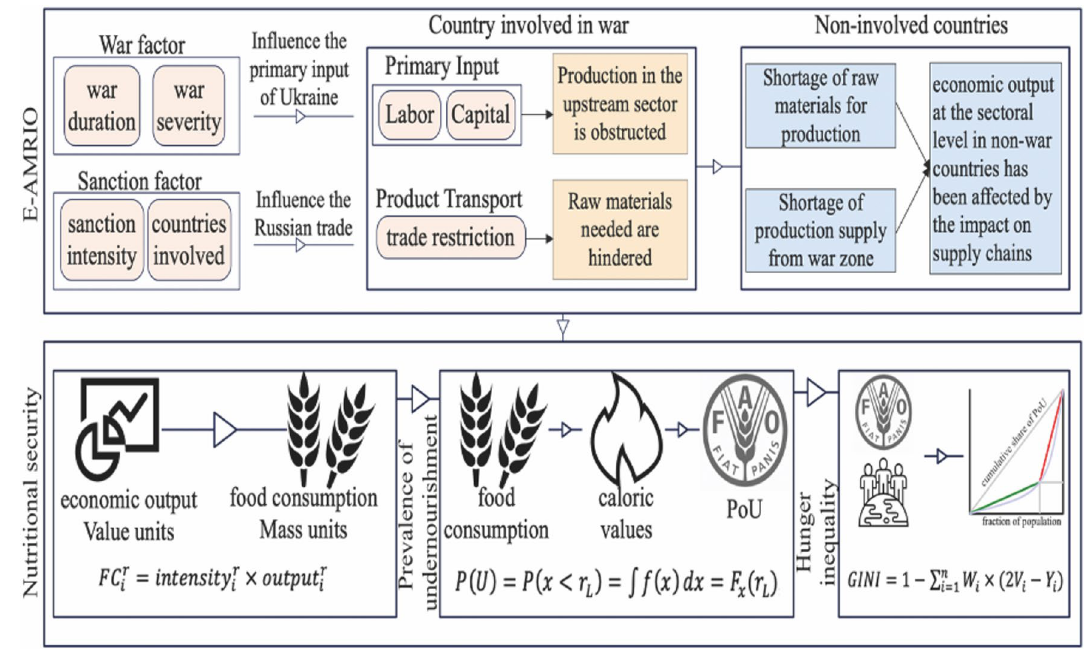
Fig. 1 Overview of the backbone of the